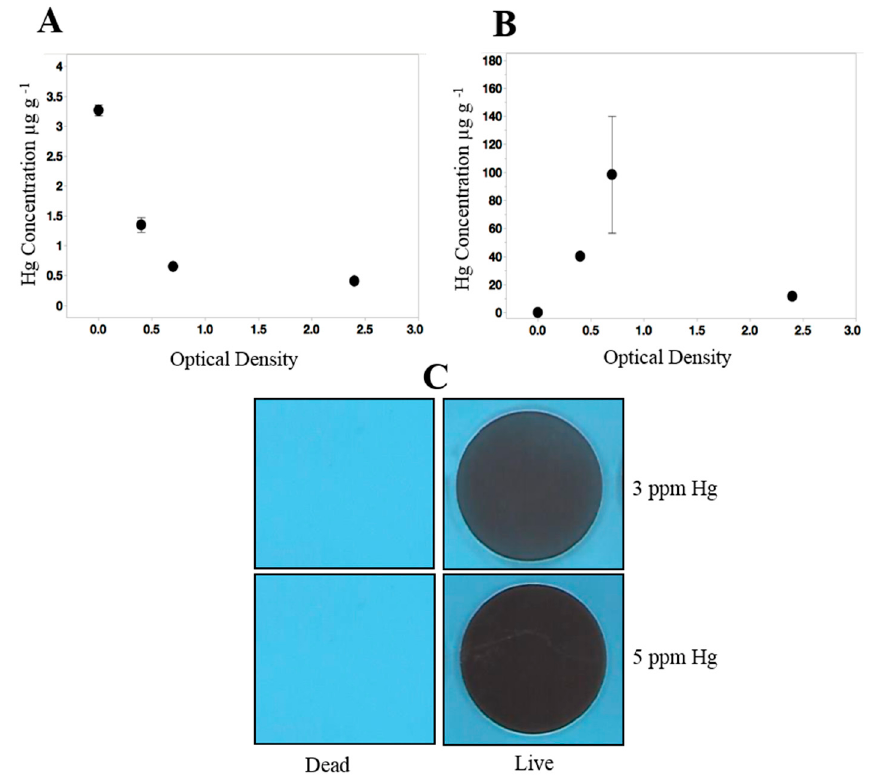
Figure 2. Hg removal potential of strain Stenotrophomonas sp. from the supernatant (A) and pellet (B) fractions is shown. (C) Hg volatilization assay from live and dead cells of Stenotrophomonas sp. treated with 3 and 5 µg/mL Hg. The experiment was performed in triplicate and representative images are shown here.